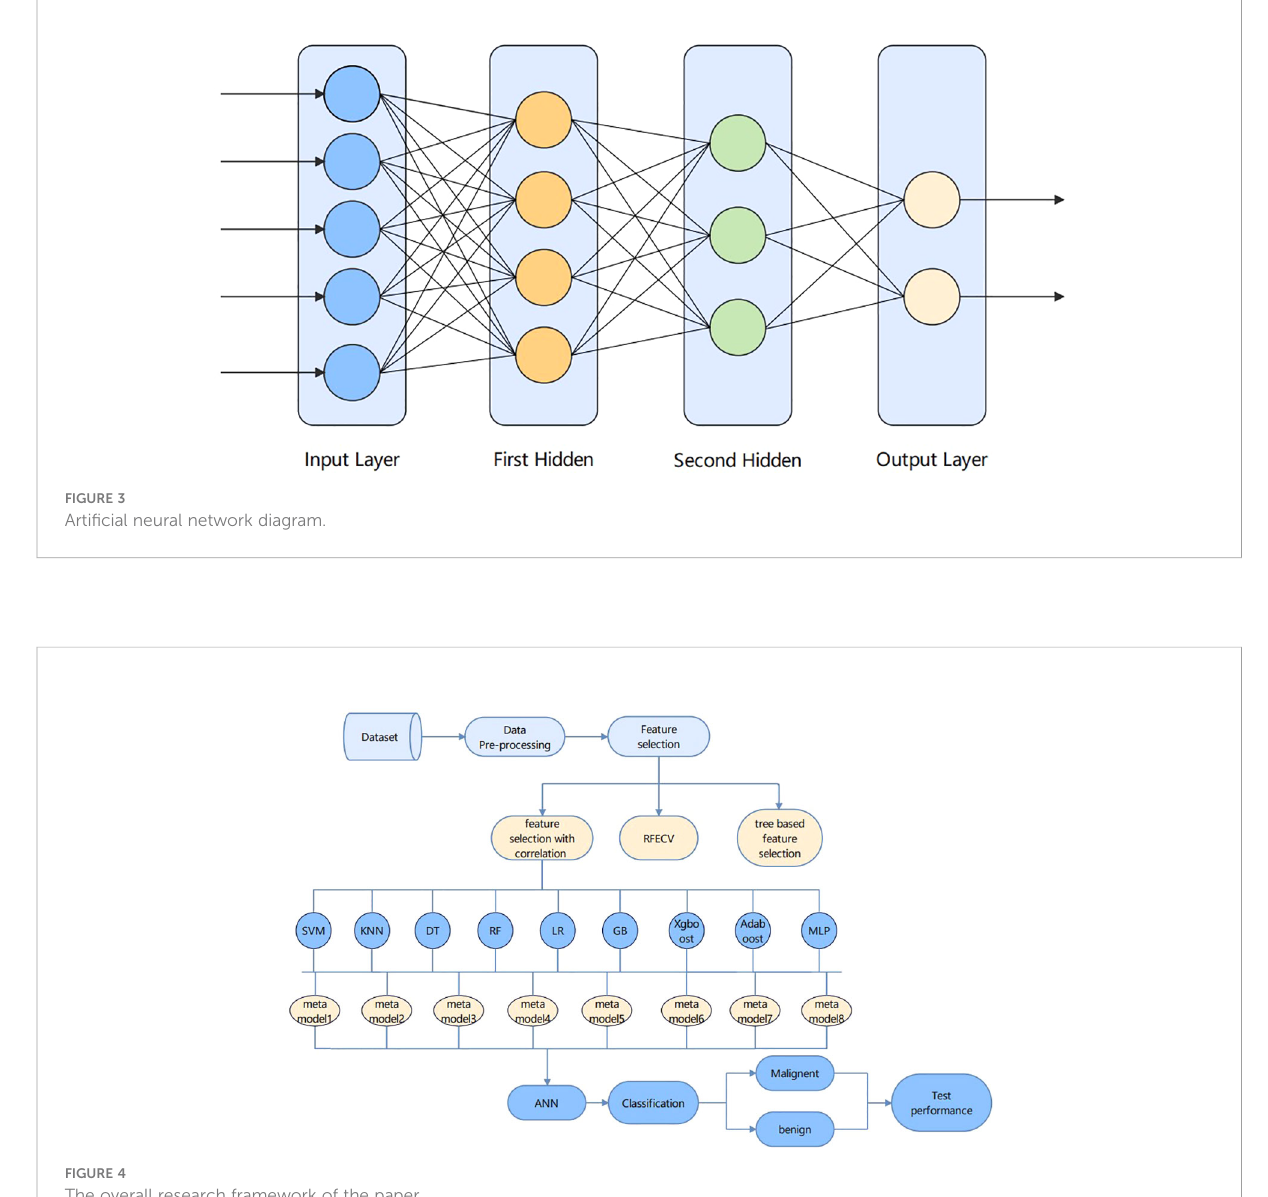
FIGURE 4 The overall research framework of the paper.